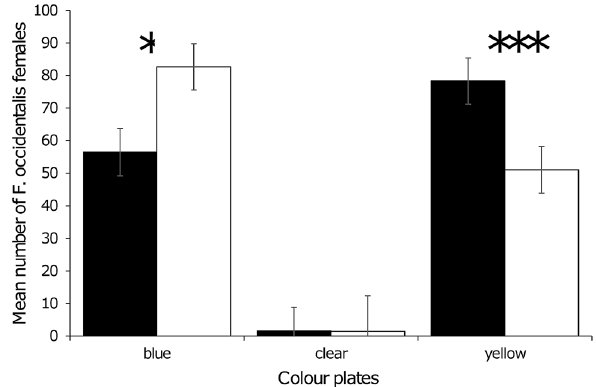
Figure 6. Mean number of Frankliniella occidentalis caught on coloured plates with Stikem glue (white bars) and D41 glue (black bars) in greenhouses (N = 14–17). Statistical result are based on normalised values. * P < 0.05, *** P < 0.001. Error bars represent standard error